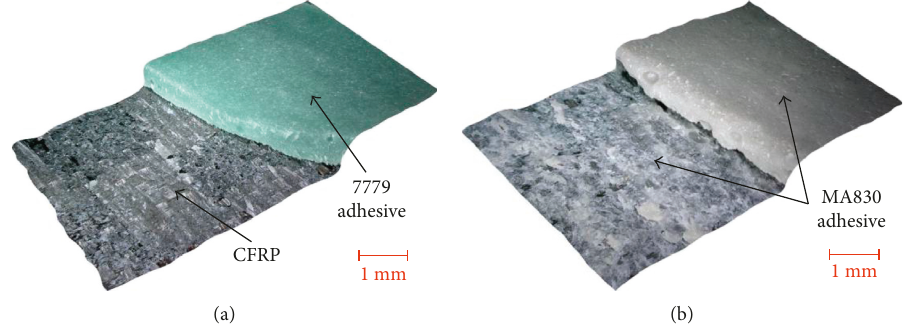
Figure 9: The morphology of the facture surfaces confirms the (a) interface failure and (b) cohesion failure (observed through a digital microscope KEYENCE